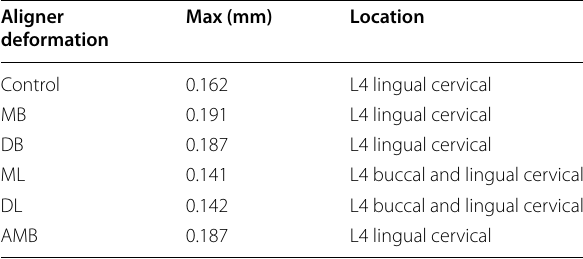
L4: the mandibular first